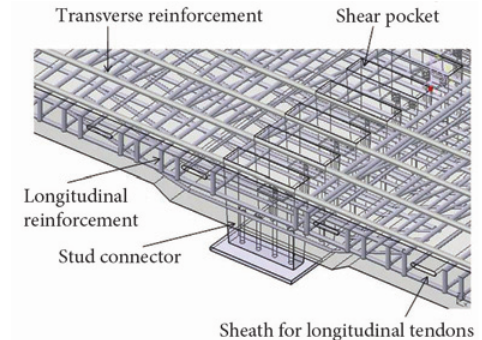
Fig. 2. Shear connection for precast